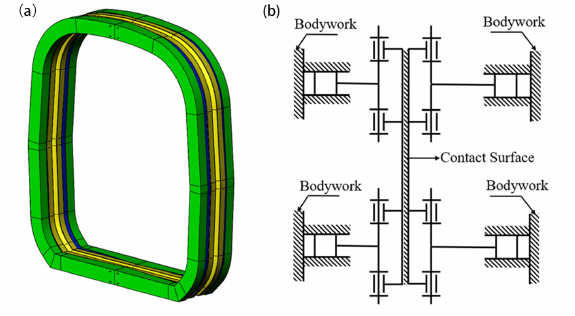
Fig. 1. Schematic diagram of the mechanical windscreen structure: (a) Overall structure diagram (b) Working principle